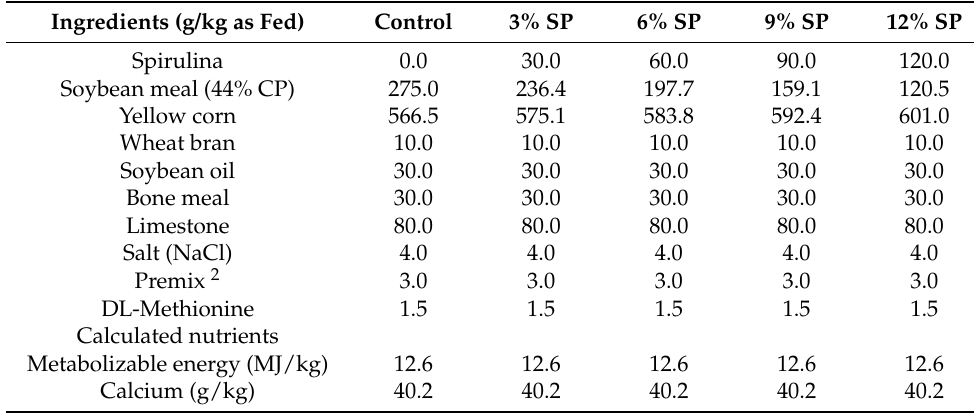
Table 2. Composition of the experimental diets 1